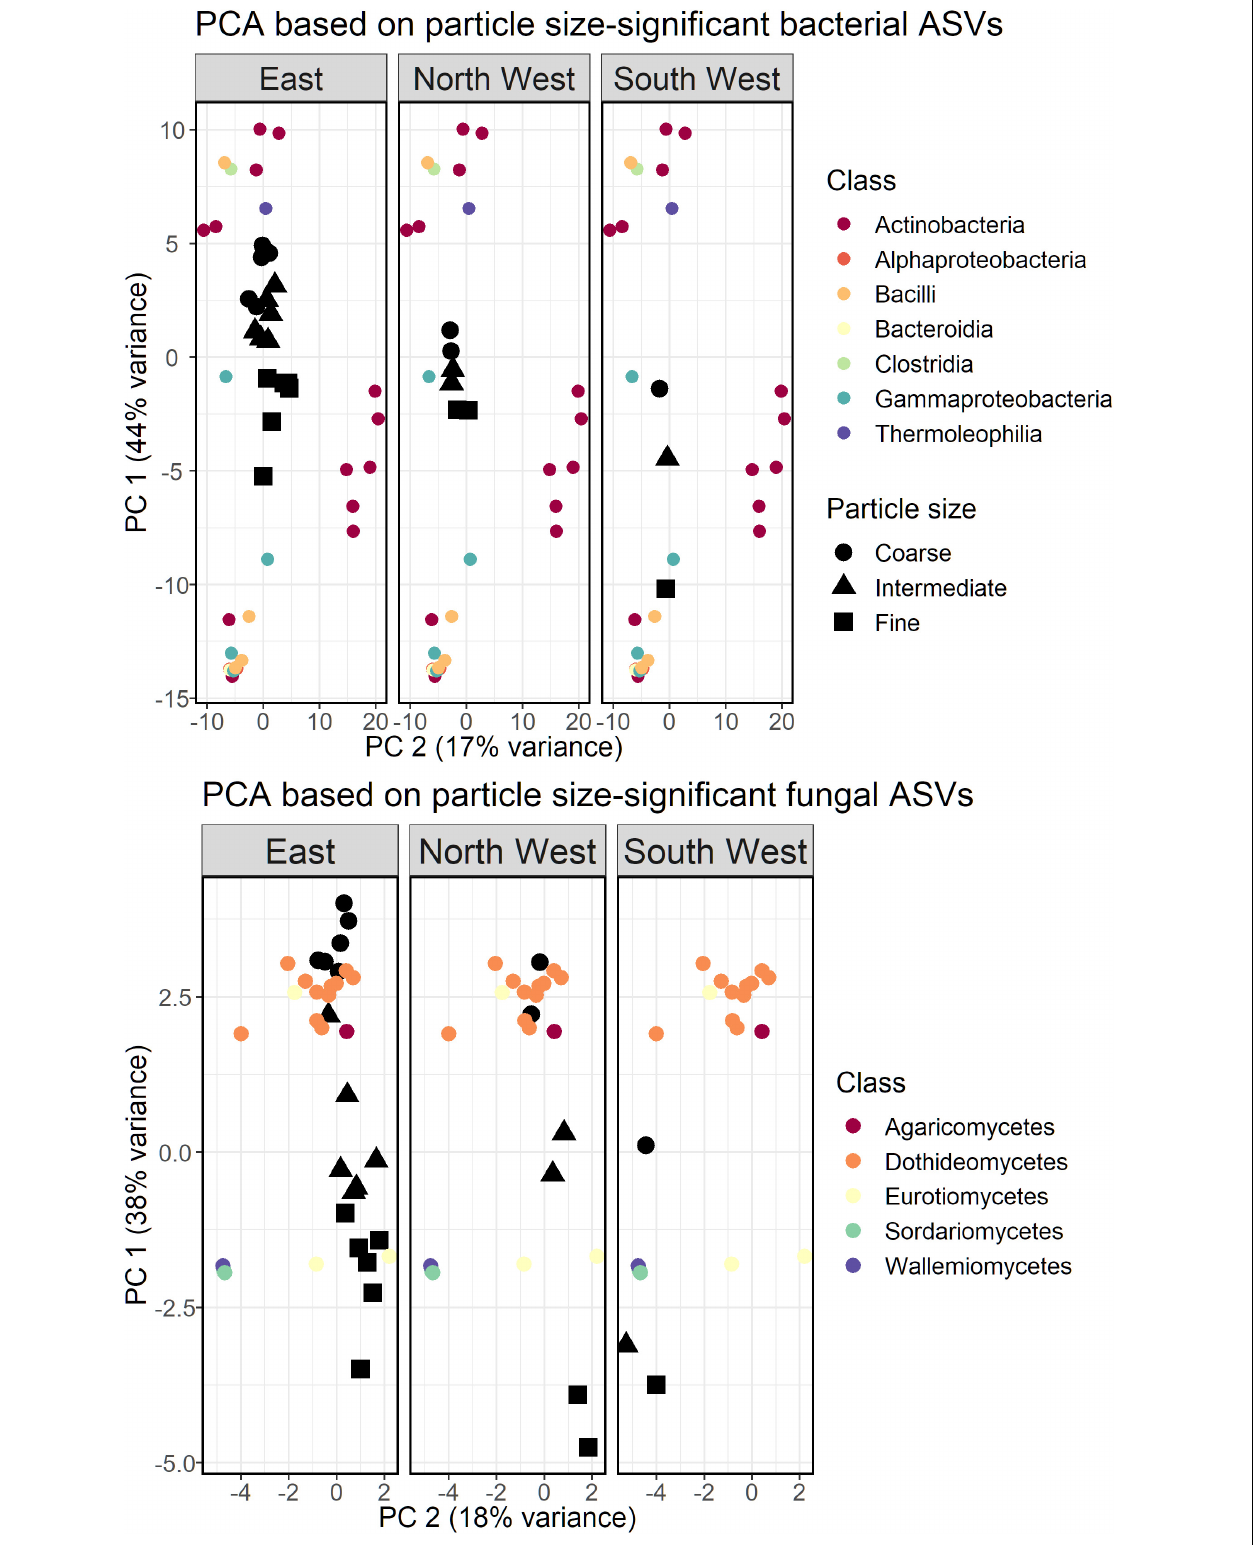
FIGURE 6 | PCA bi-plot based on a subset of bacterial (Top) and fungal (Bottom) ASVs found to be linked to the size-class of the collected particulate matter. East source refers to East and East-Dust, combined.